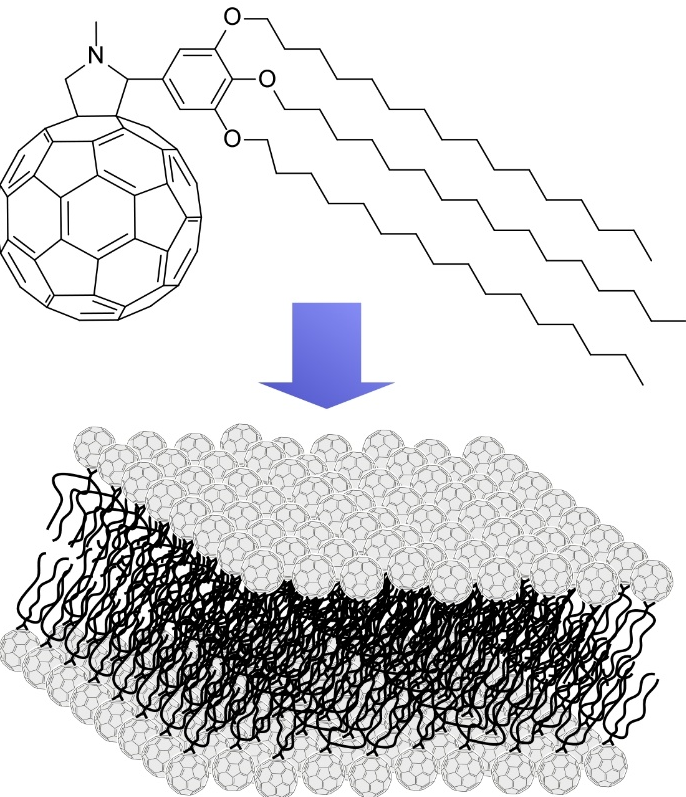
Figure 9. Formation of two ‐ dimensional nanosheet from alkylated C 60 derivatives with sp 3 ‐ carbon ‐ based three C 16 alkyl chains and sp 2 ‐ carbon ‐ based C 60 moiety.